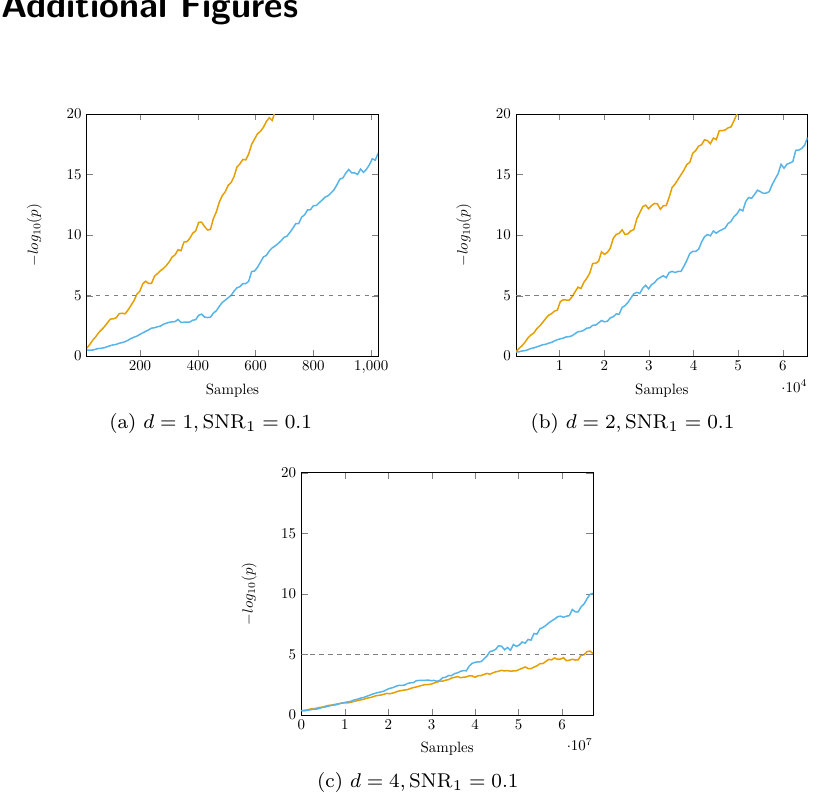
Figure 11: Performance of the (orange) t -test and (blue) χ 2 -test for simulated univariate 1st-, 2nd-, and 4th-order leakage with SNR 1 = 0 .